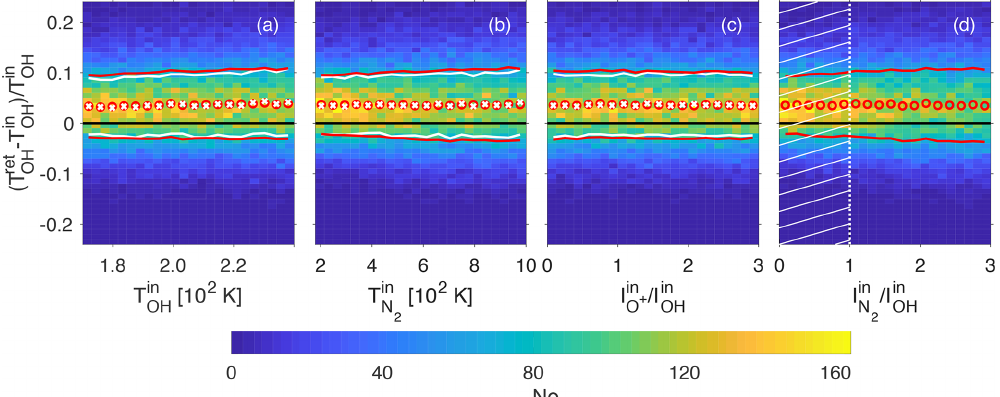
Figure 9. 2-D histograms of parameter retrieval tests showing the fractional error on OH temperature retrieval when the synthetic spectra are constructed using a different source for the transition probabilities of the OH lines (Langhoff et al., 1986) than used in the retrieval process (Mies, 1974). Red circles indicate mean values and red lines are 1 standard deviation on either side of the mean. The white crosses and white solid lines in panels (a, b, c) represent mean values and 1 standard deviation on either side of the mean, respectively, but only including spectra for the N 2 intensity within the hatched area shown in panel (d) .